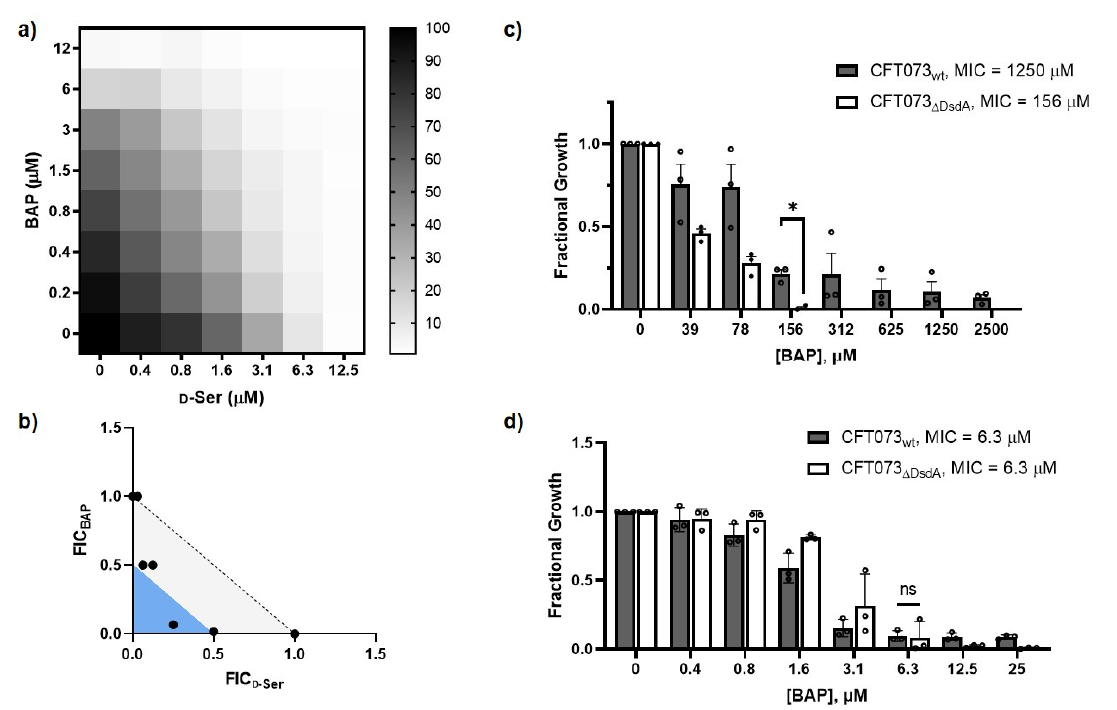
Figure 5. Combining BAP and D -Ser against CFT073 Δ DsdA grown in MOPS-glycerol shows an additive-to-synergistic relationship, and an increase in sensitivity to D -Ser relative to CFT073 wt . ( a ) Representative checkerboard analysis showing a heat plot with fractional growth at various combinations of BAP and D -Ser; ( b ) Isobologram analysis with points depicting FIC at fractional growth <10%; light gray region indicates additivity (FIC I ˃ 0.5 and ˂ 1.0), blue region indicates synergy (FIC I ≤ 0.5), white region indicates no relationship. FIC I were observed in the range 0.32–1.03 across experiments for all concentrations; ( c ) CFT073 Δ DsdA sensitization to BAP in pooled human urine (MIC = 156 µM) compared to CFT073 wt (MIC = 1250 µM), n = 3, error bars represent standard error; ( d ) CFT073 Δ DsdA is not sensitized to BAP in MOPS-gly compared to CFT073 wt (MIC = 6.3 µM), n = 3; error bars represent standard error; data for all three replicates shown (); p > 0.05 (ns); p ≤ 0.05 (*); p ≤ 0.01 (**); p ≤ 0.001 (***).